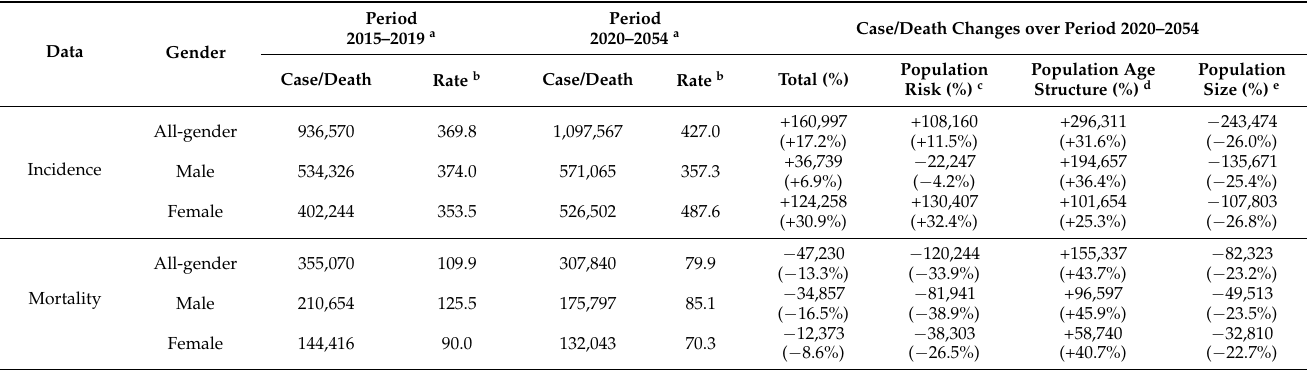
Table 1. All-site and all-age combined cancer incidence and mortality by gender and decomposition of changes in new cancer case/death over